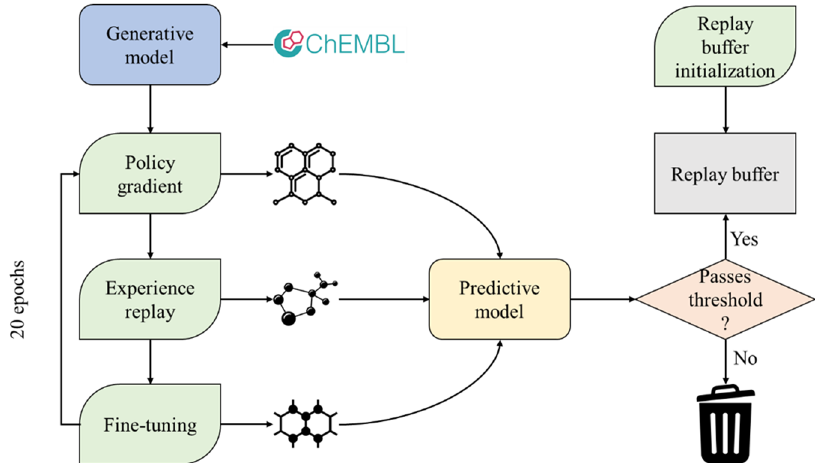
Fig. 1 Pipeline of model training. The model was pre-trained on ChEMBL data and then trained for 20 epochs. Each epoch consists of three steps: policy gradient, policy experience replay, and fi ne-tuning. At the end of each step, 3200 molecules are generated, and molecules with predicted activity exceeding the probability threshold are admitted into the replay buffer. The replay buffer, in turn, in fl uences training at the policy replay and fi ne-tuning steps. At the end of the training, the model generates 16,000 molecules for evaluation. We modi fi ed the number of iterations for all 3 steps in each epoch to understand their effects on training. We also used different libraries to initialize the replay buffer to understand how the replay buffer can in fl uence model